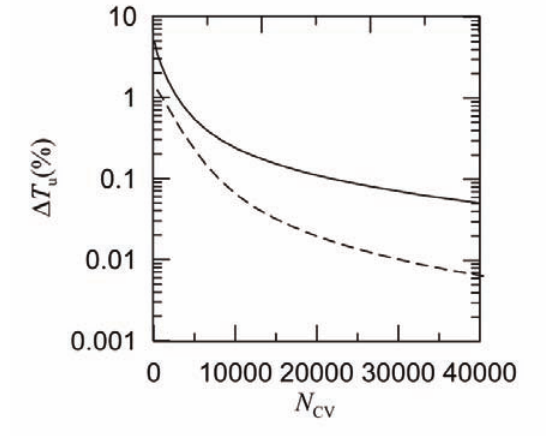
Figure 9. Numerical tests on the heat conduction equation. Percentage errors D T as function of the number N u computational mesh at 301 s of cooling. Solid line, D T numerical and analytical solutions. Dashed line, D T grid and the coarser grid computed with a grid step of 10 × 10 CVs.